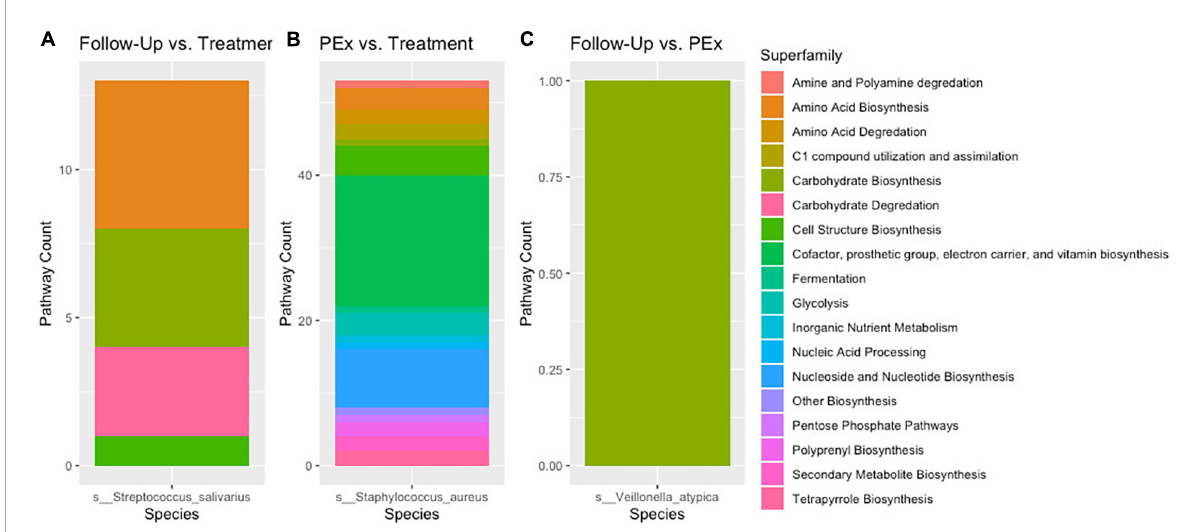
FIGURE7 Stratified differential pathway abundance. Panel (A) Metabolic pathways attributed to Streptococcus salivarius were differentially abundant between follow-up and treatment. Panel (B) Metabolic pathways attributed to Staphylococcus aureus were differentially abundant between pulmonary exacerbation and treatment. Panel (C) A single metabolic pathways attributed to Veillonella atypica was differentially abundant between follow-up and pulmonary exacerbation. When comparing the metabolic pathways between clinical states (i.e., pulmonary exacerbation, end of treatment, and follow-up), only one bacterial species was differentially abundant between each comparison. The different metabolic pathways are shown in different colors for each bacterial species. PEx, pulmonary